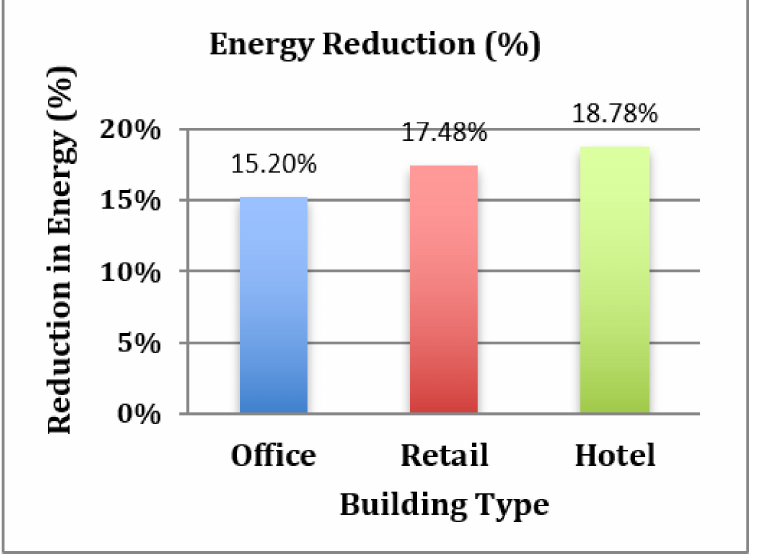
Figure 4. Average energy reduction achieved